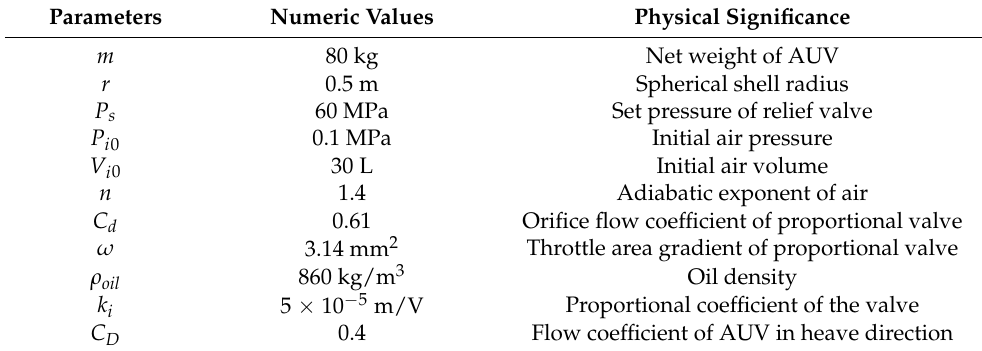
Table 3. Designed parameters of deep-sea AUV.